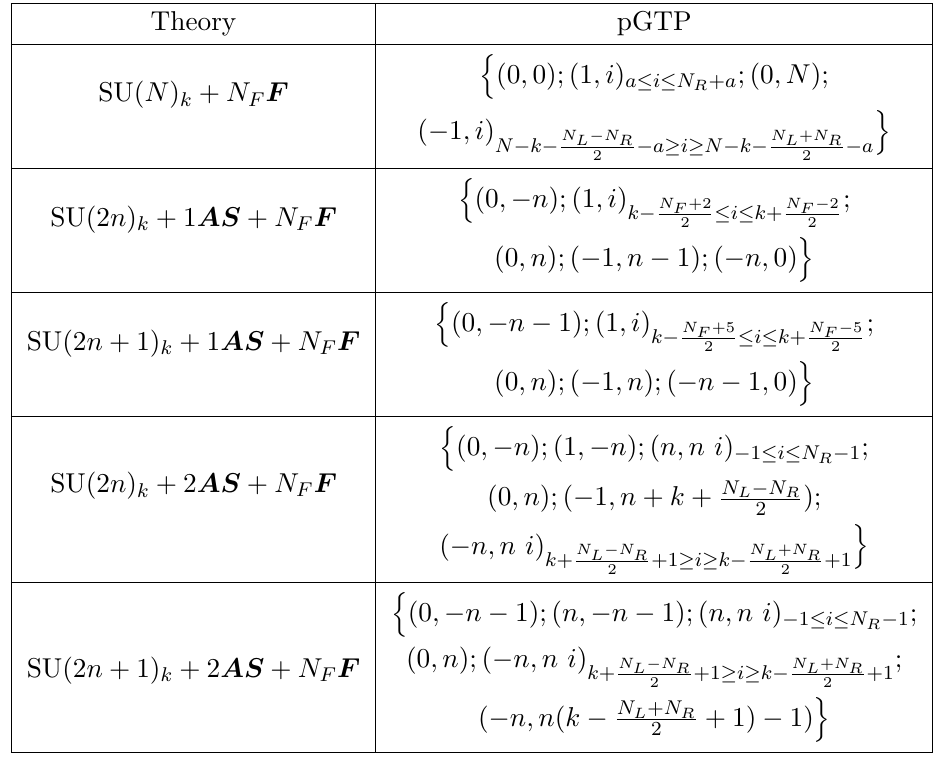
Table 5 . Construction of toric polygons (not necessarily convex) for the theories studied in this paper. For each theory, we give a list of pairs of integers which should be interpreted as the list of coordinates of the black dots defining the polygons in counter clockwise order; the white dots can then be added on the points of the interior of the edges with integer coefficients. The free parameter a can take any integer value, parametrising the SL(2 , Z ) -frame. The polygons presented here can be deduced from the brane webs constructed in